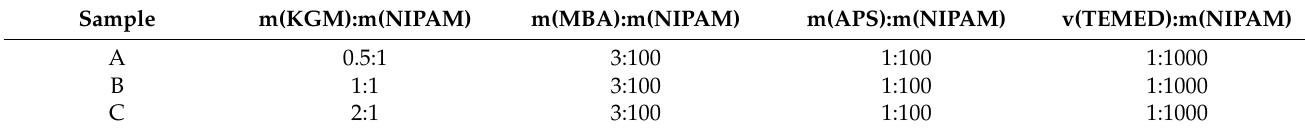
Figure 1. ( a – c ) three different ratio gel inversion experiments. Table 1. Feed ratio scheme for formulating IPN (KGM/NIPAM) hydrogel.